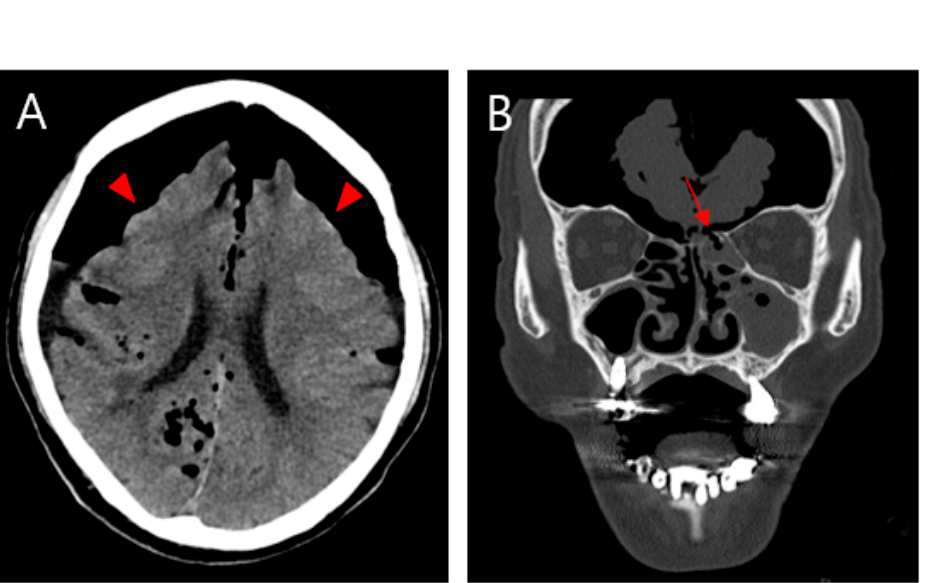
Figure 1. ( A ) Non-contrasting brain CT image showing pneumocephalus between the tips of the frontal lobes and the interhemispheric fissure, causing brain compression and demonstrating the Mount Fuji sign (arrowhead). ( B ) CT image of the paranasal sinus shows a fracture of the left ethmoidal roof (arrow). An 81-year-old male patient was admitted to our emergency room (ER) with mental cloudiness. Three hours prior to admission, he had slipped and tripped over a branch, injuring his nose. His initial Glasgow Coma Scale (GCS) was 11 (eye, 2; verbal, 3; motor, 6) and he had dyspnea upon arrival at the ER. Despite the high-pressure oxygen mask therapy, the continuous increase in oxygen demand required intubation and ventilator support. A physical examination revealed swelling, redness and bruising around his nose and a large amount of bloody rhinorrhea. A neurological examination revealed no specific findings other than decreased consciousness with